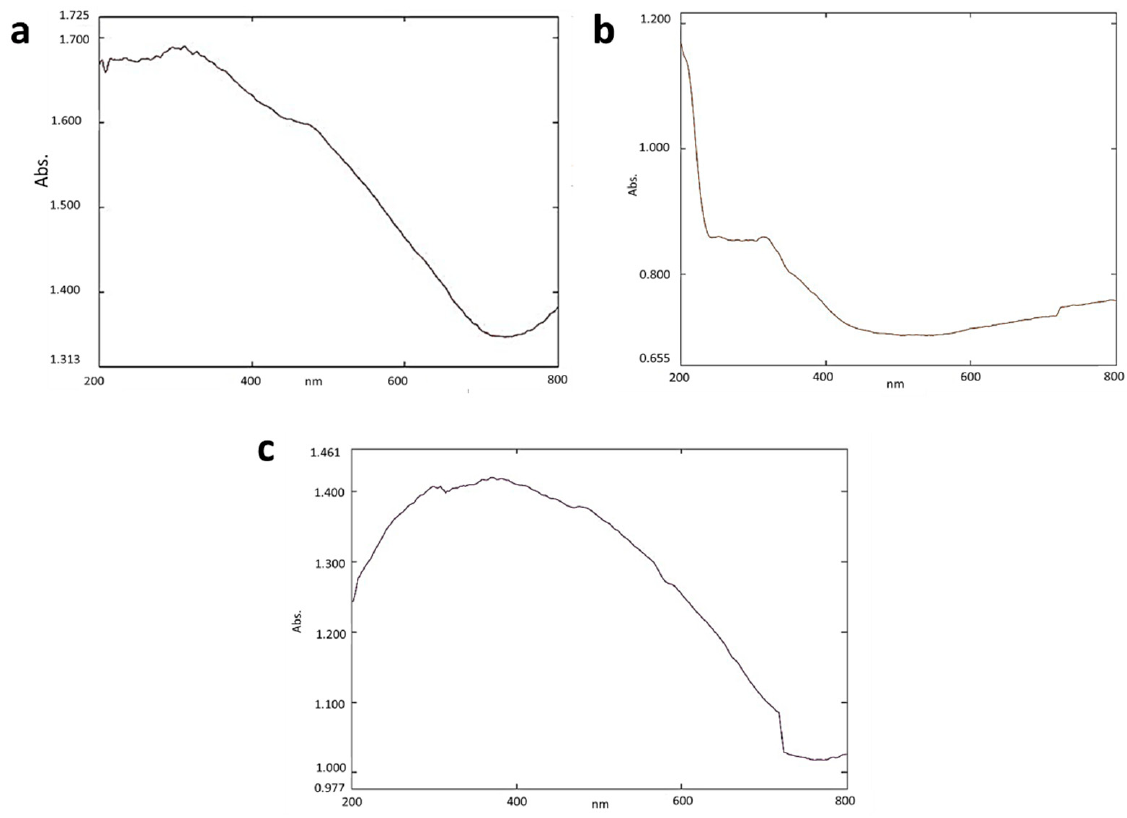
Figure 1. UV—Vis analysis of ( a ) SPIONs ( b ) Alginate beads ( c ) Alginate–SPIONs microspheres.